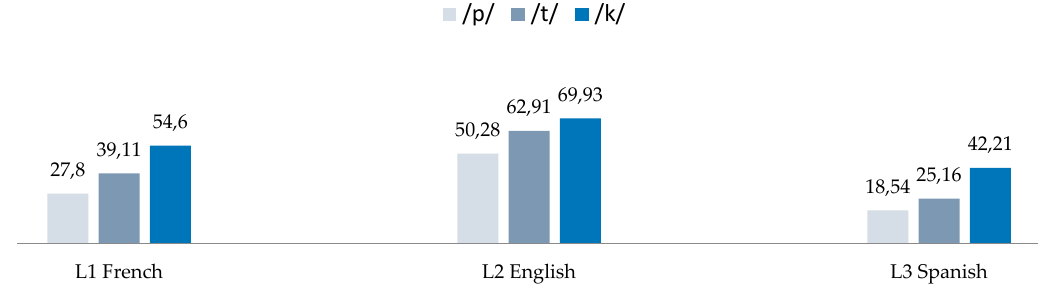
Figure 3. Mean VOT (ms) in the voiceless stops of Group TF in L1 French, L2 English and L3 Spanish. Languages 2018 , 3, 30